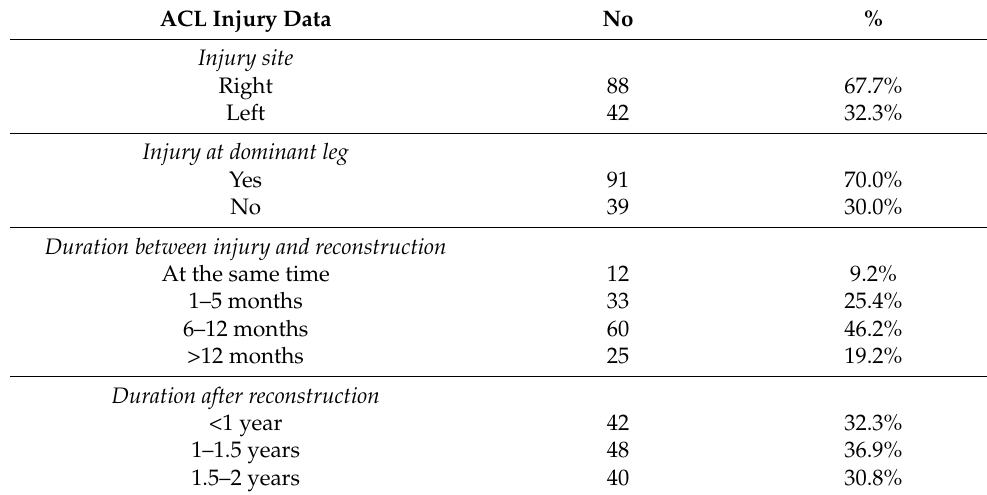
Table 2. Injury data of patients undergoing ACL reconstruction in Aseer Central Hospital, Saudi Arabia.